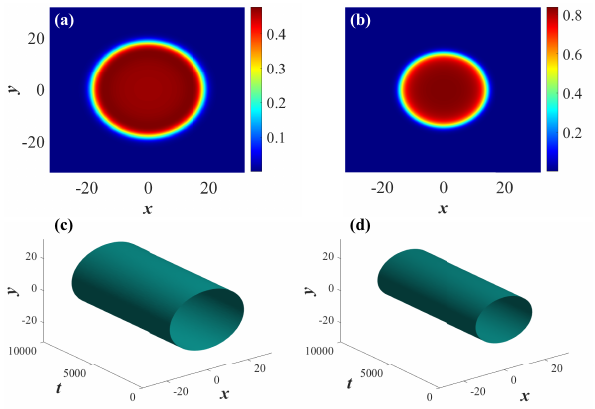
Figure 2. Typical examples of the stable fundamental QDs produced by Equation (4). Panels ( a , b ) display the density profiles of the QDs with ( N , κ ) = ( 1000,0.05 ) and (1000, − 0.05). ( c , d ) The perturbed evolutions of the QDs shown in Panels ( a , b ), produced by simulations of Equation (4) with 1% random noise added to the input.